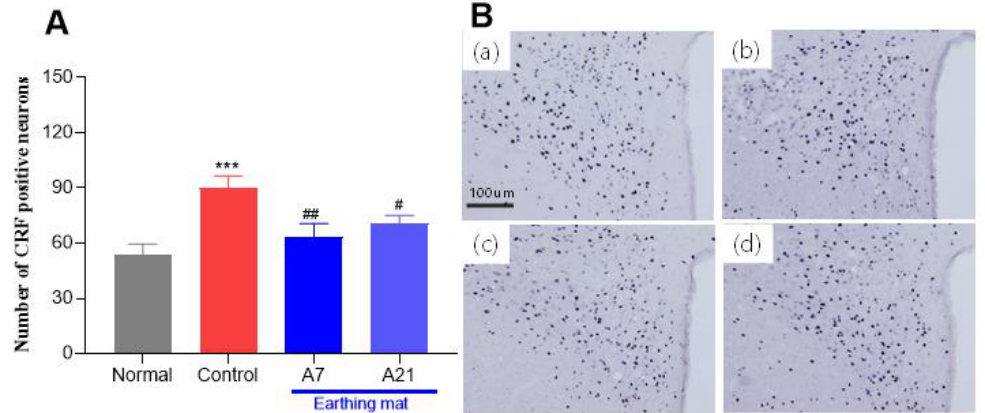
Figure 4. Effect of earthing mat on elevated plus maze. ( A ): Time to open arm (%), ( B) : Time to closed arm (%), ( C ): Total distance (cm).